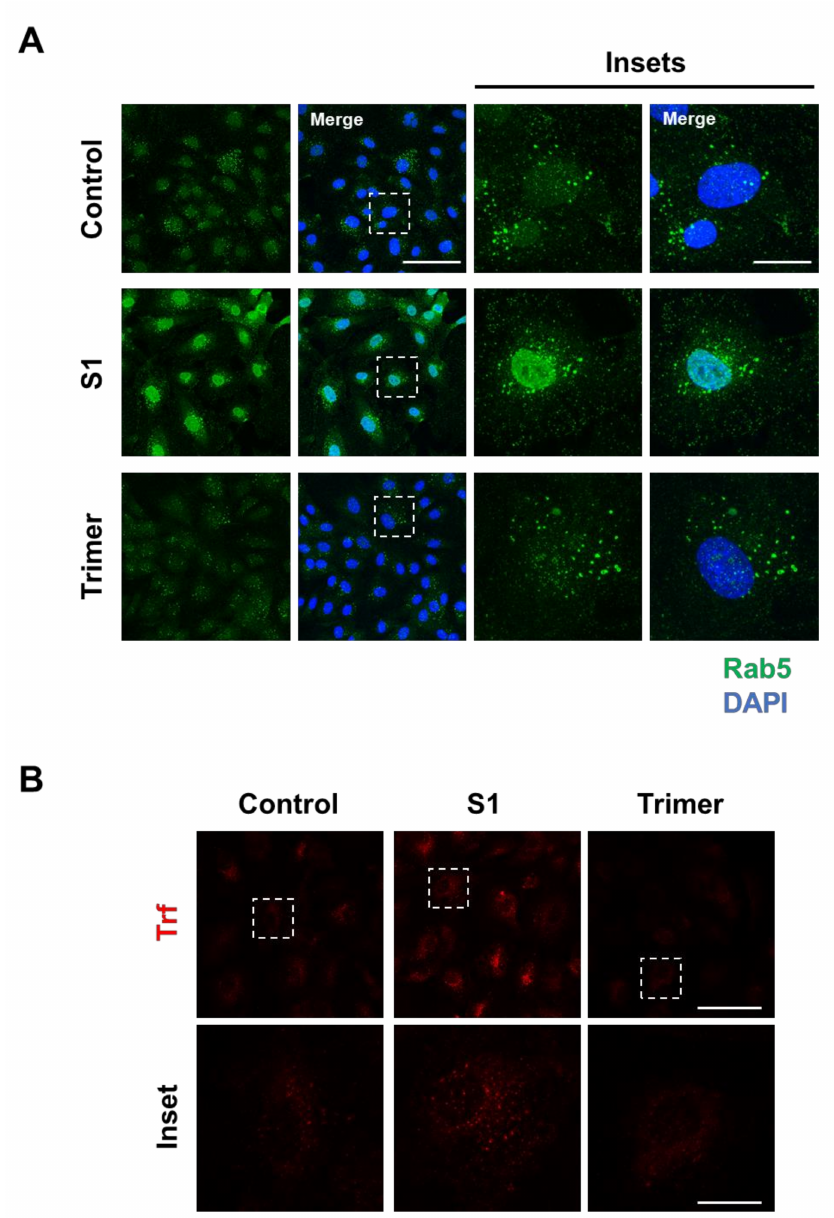
Figure 2. Endosomal trafficking is altered by the treatment of the spike proteins in the human brain ECs. ( A ) Human primary brain ECs were treated with 15 nM of S1 domain of spike protein (S1) or active trimer (Trimer) for 2 h, respectively. Cells were stained with Rab 5 (green). DAPI (blue) indicates nucleus. Insets indicate magnified images of squares of dashed lines. Scale bars 75 µ m (left panel); 20 µ m (right panel). ( B ) 10 µ g/mL of human transferrin conjugated with Texasred (Trf, red) and 15 nM of S1 or Trimer were treated in the human primary brain ECs for 2 h, respectively. Scale bars, 75 µ m (upper panel); 20 µ m (bottom panel). Insets indicate magnified images of squares of dashed